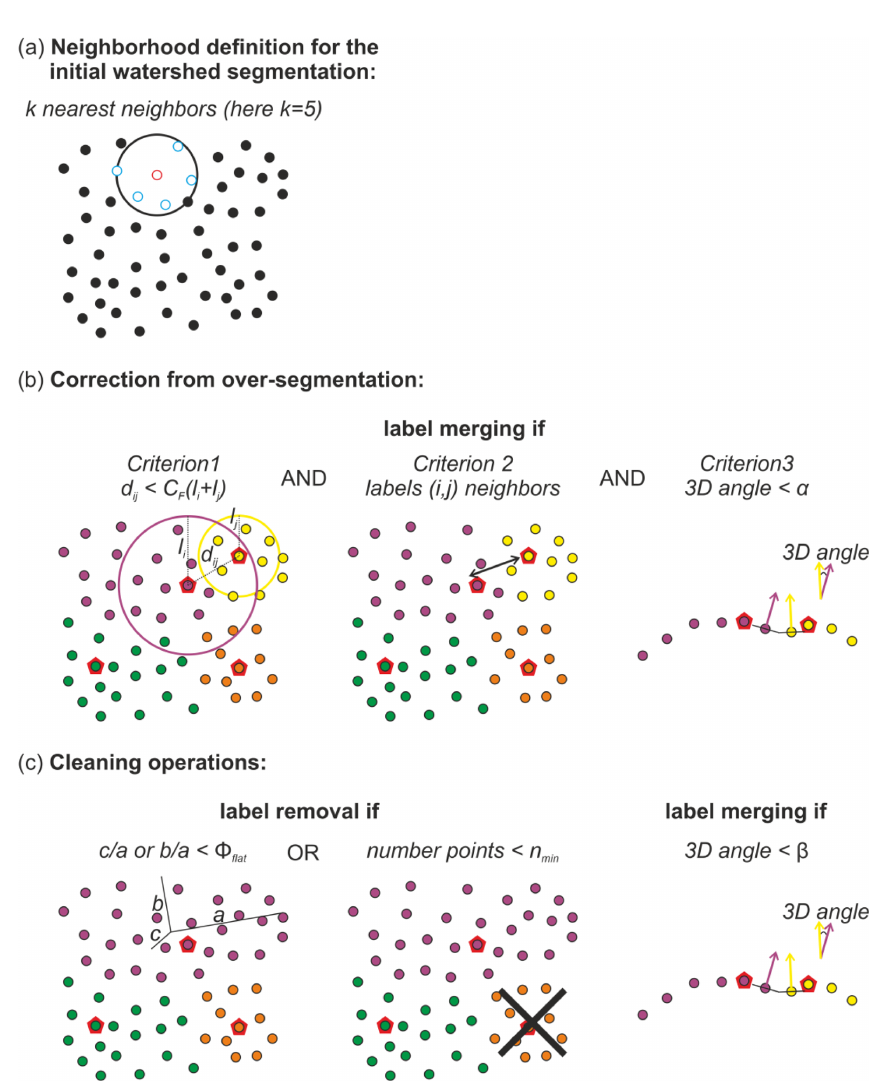
Figure A1. Schematic schemes illustrating the different parameters of G3Point used during (a) the initial watershed segmentation (see Sect 2.1), (b) the correction of the initial segmentation from over-segmentation by grain merging (see Sect. 2.2) and (c) the cleaning of the segmentation by various operations (see Sect. 2.3). Black or color circles represents the points of the point cloud. The blue points represent the k nearest neighbors of the red point in caption (a) . Labels in captions (b) and (c) are shown by the color of the points, and the summit (or outlet) of each grain is represented by a red